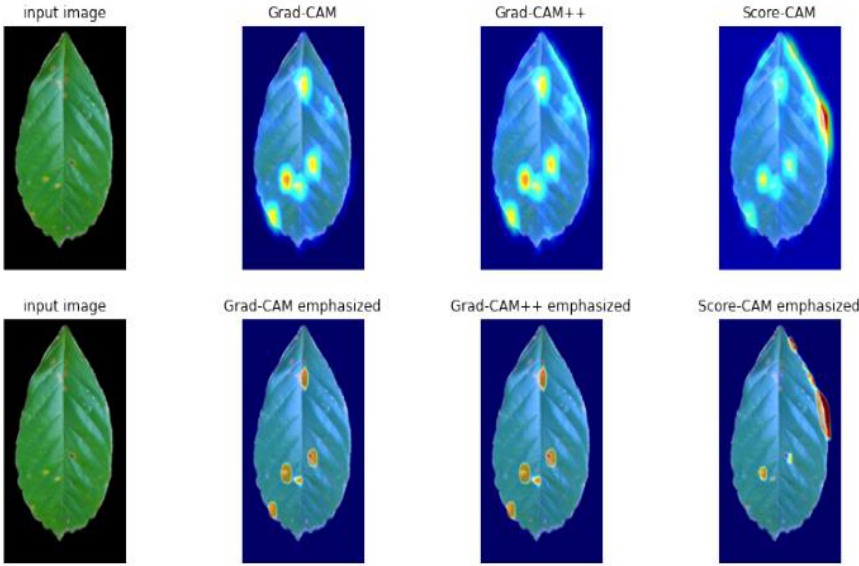
Figure 15. Visualization Result of Grad-CAM, Grad-CAM++, and Score-CAM.